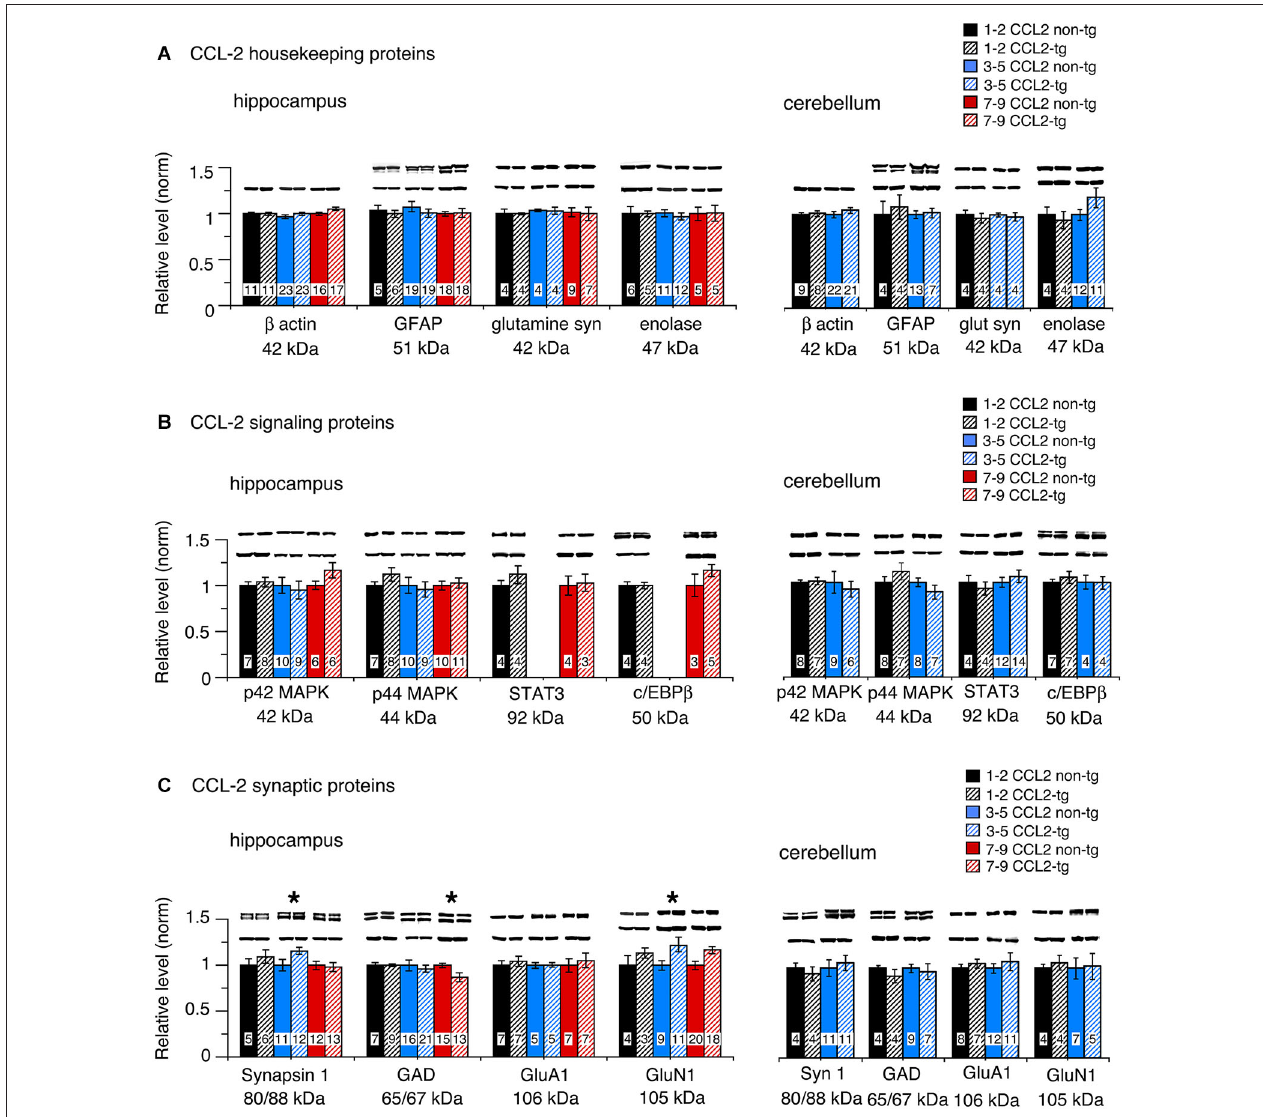
Western blots are shown above the respective bar. Top blot is the protein indicated for the graph; bottom blot is β actin in the same lane. Numbers in bars are the number of animals measured. * = statistically significant difference between CCL2-tg and non-tg for the age